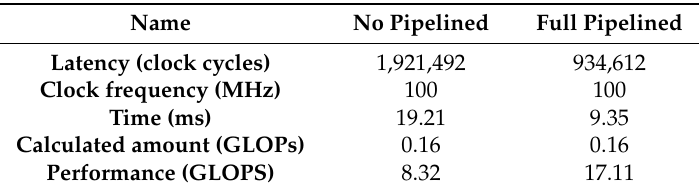
Table 4. Comparisons of the first layer.